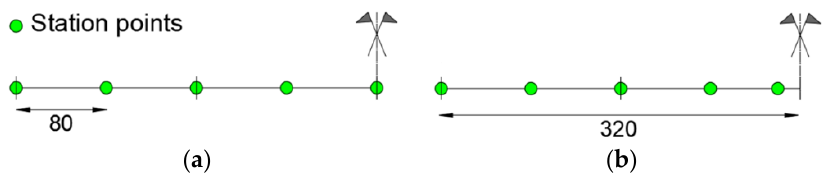
Figure 18. Modeling left-half of the structure configurations: ( a ) plasticized zone with station point; ( b ) plasticized zone without station point.